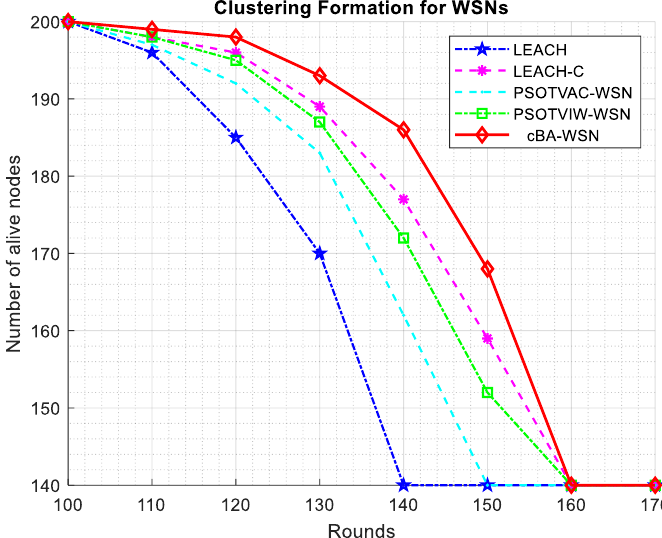
Figure 7. Comparison of advanced cBA-WSN for the number of nodes alive for a WSNs with PSO-TVAC, PSO-TVIW, LEACH, and LEACH-C approaches.